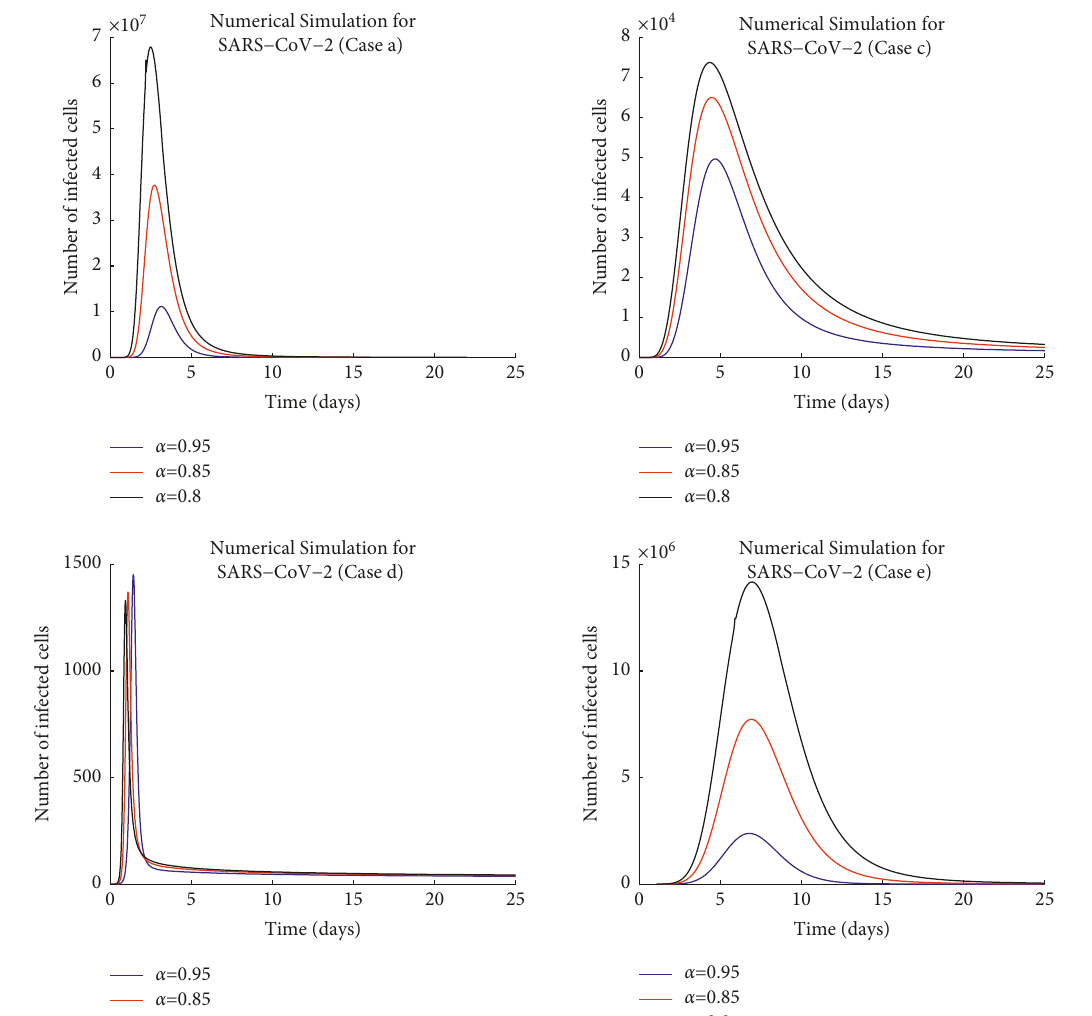
Figure 6: Numerical simulation results of SARS-CoV-2 behavior in patients a , c , d , e